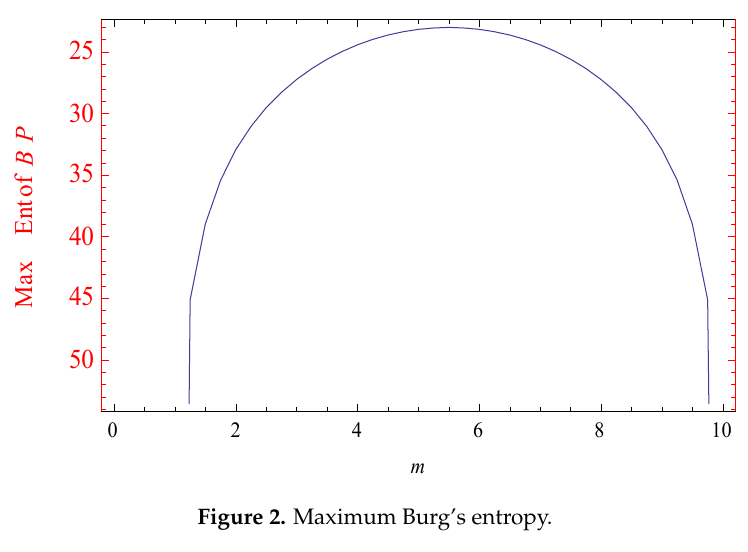
Figure 2. Maximum Burg’s entropy.